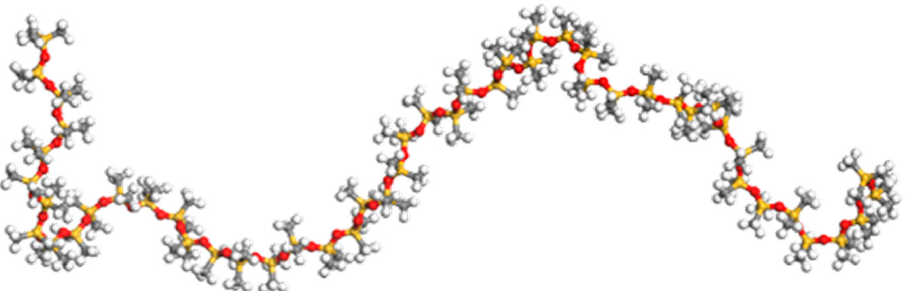
Figure 2. Representation of a PDMS single chain. Color codes: carbon in grey, hydrogen in white, oxygen in red and silicon in yellow.